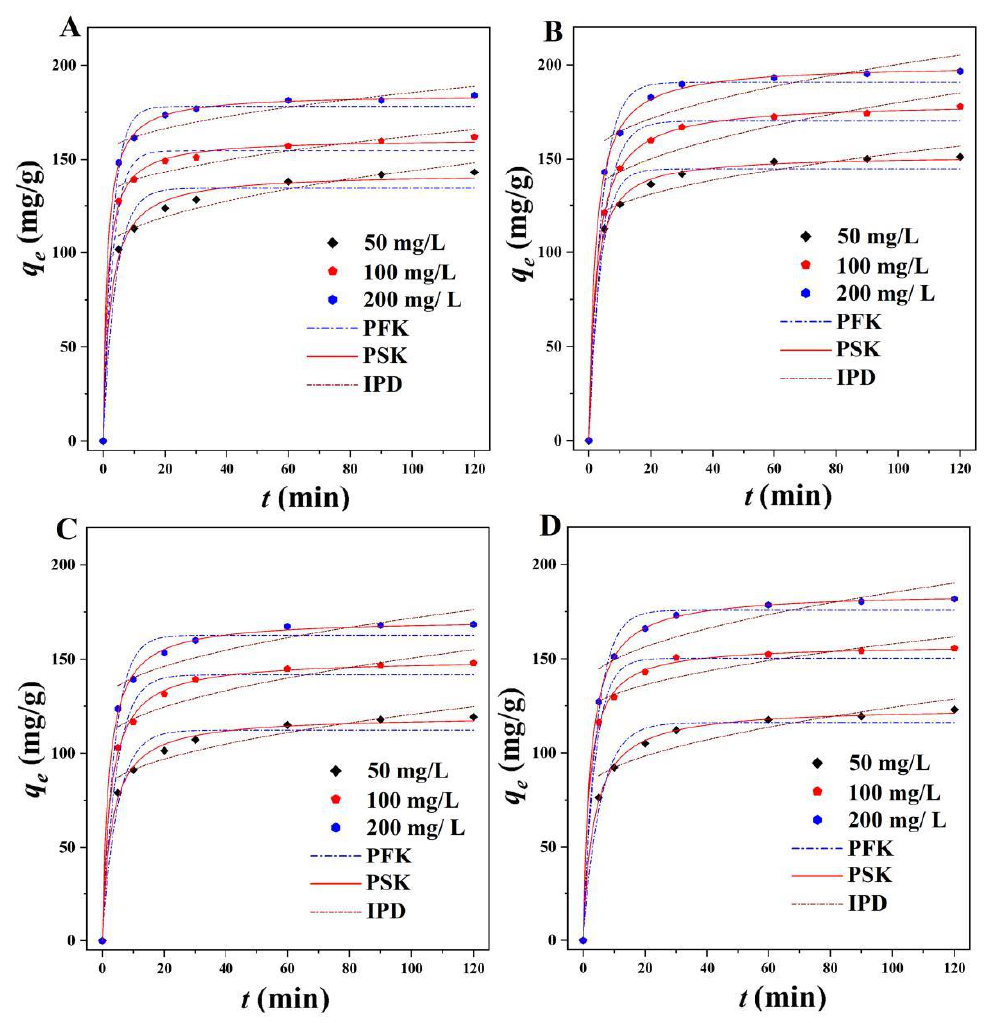
Figure 6. PFK, PSK, and IPD plots of BMFH ( A , B ) and BMFH/Fe 3 O 4 ( C , D ) for MG and TH at 303 K. Table 2. Fitting parameters of adsorption kinetic models for MG and TH at 303 K.